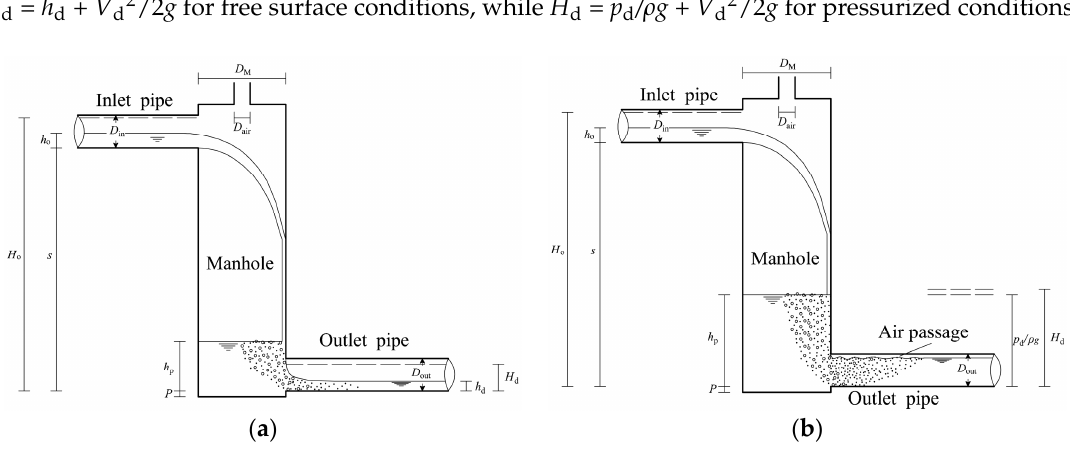
Figure 4. Definition sketch for ( a ) free surface outflow; and ( b ) pressurized outflow.